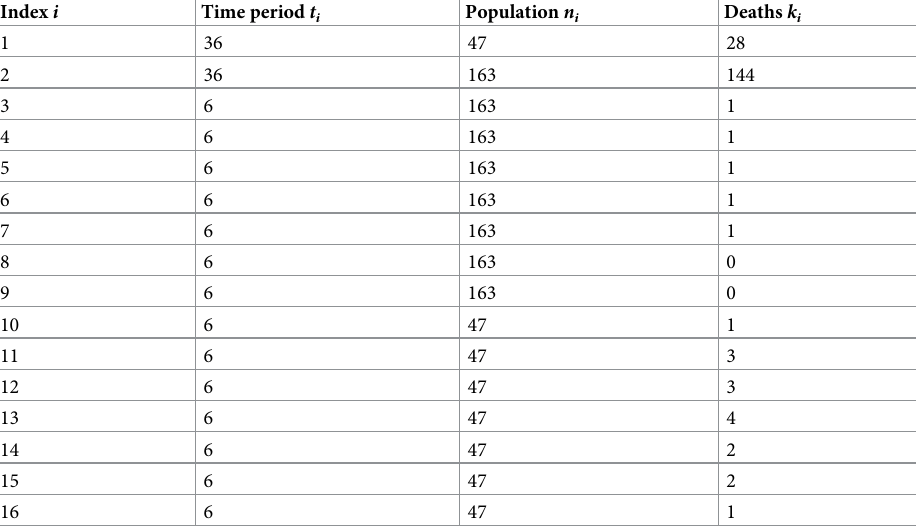
Table 2. Barkwell and Shields data at finest resolution